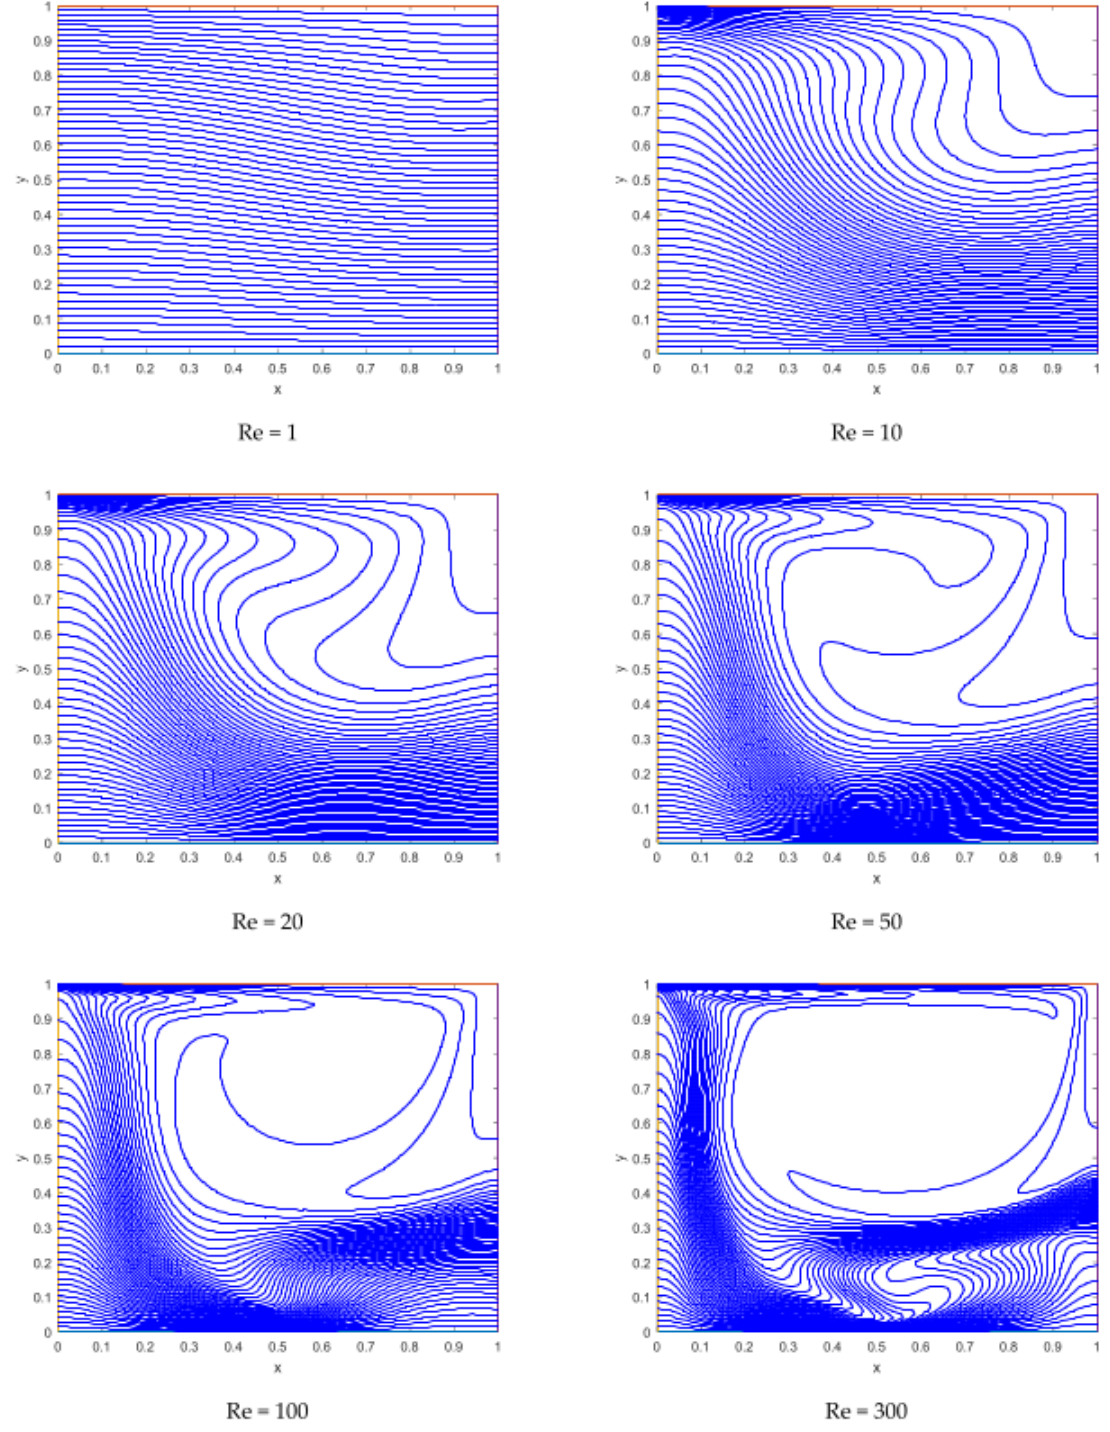
Figure 10. Representation of isotherms for different values of Reynolds